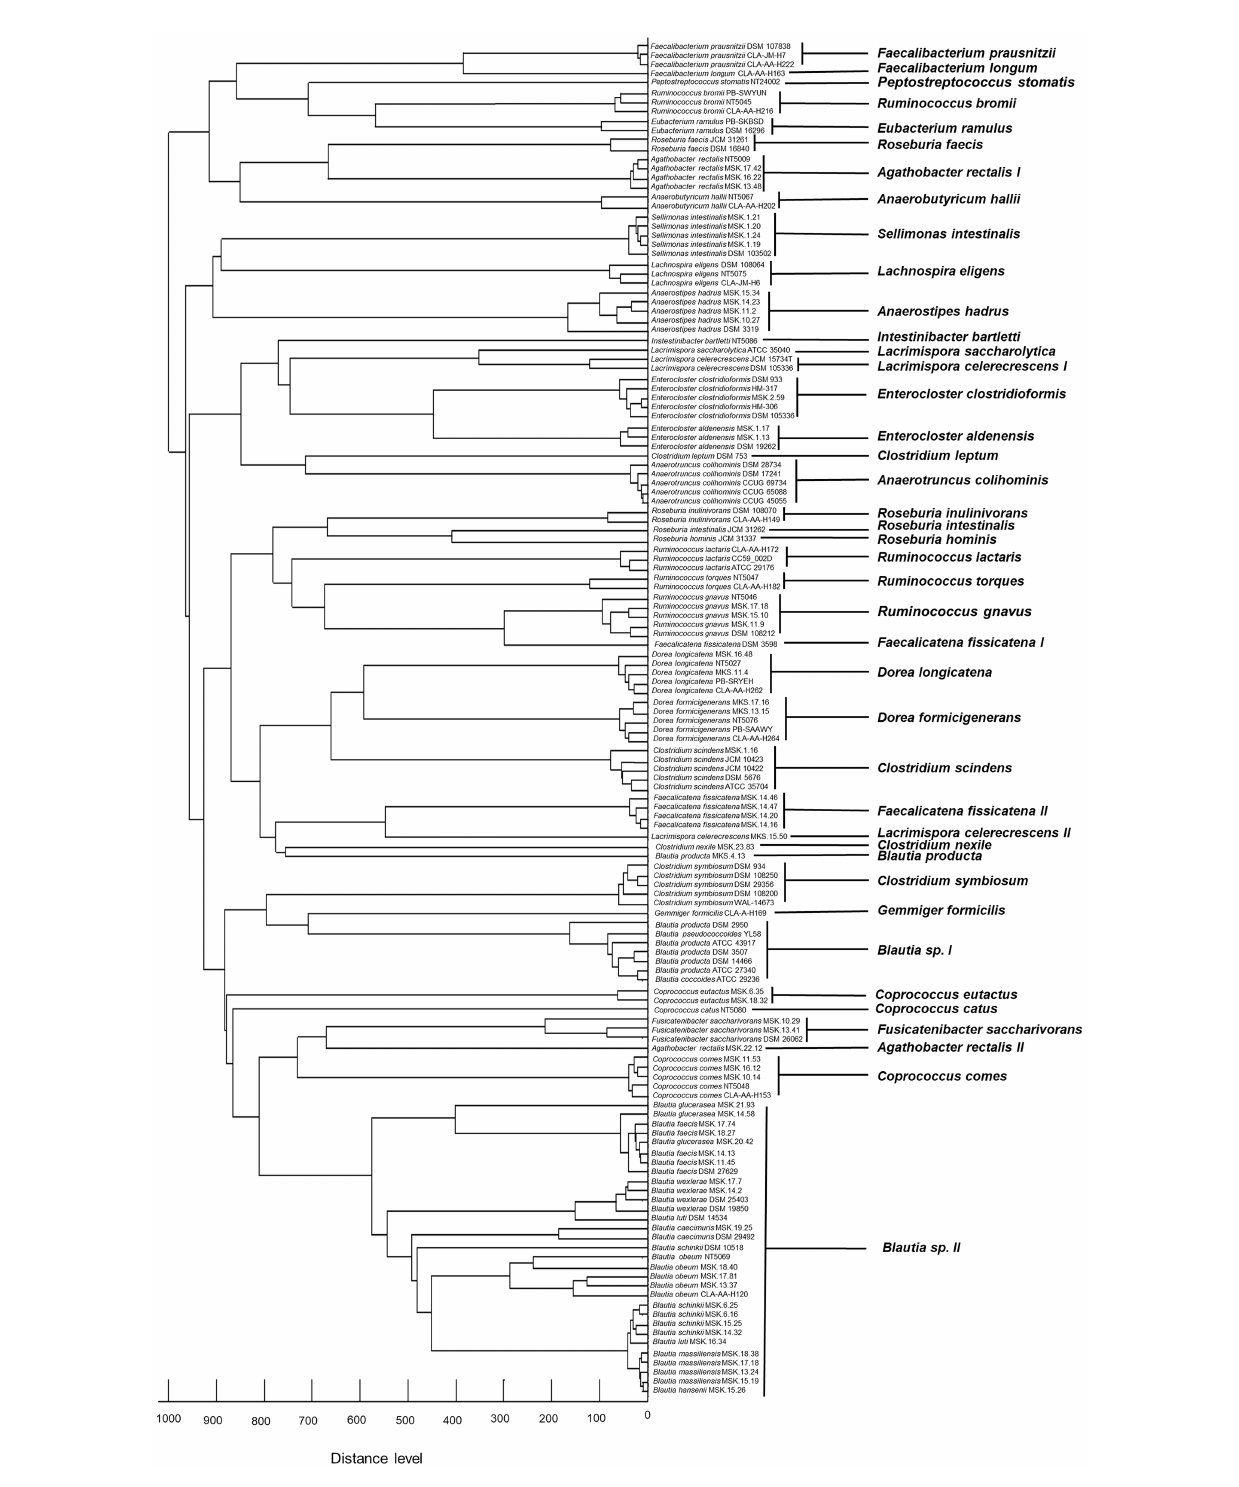
FIGURE 3 Distribution of different species with similar spectral profiles according to MSP dendrogram cluster